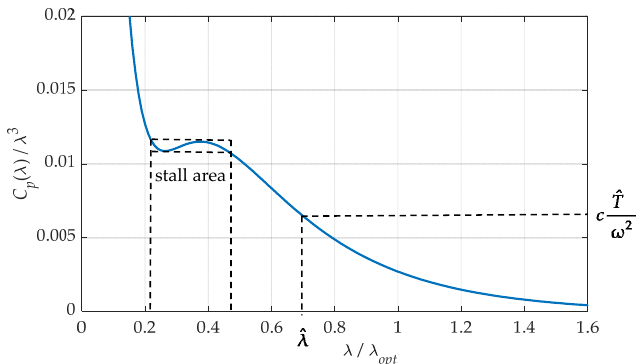
Figure 8. Finding roots of the nonlinear function, c = 2/( πρ R 5 ).